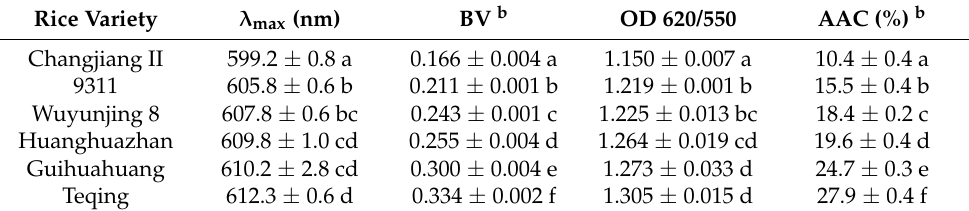
Figure 1. Iodine absorbance spectra of starches. Table 1. Iodine absorbance spectrum parameters of starches a .